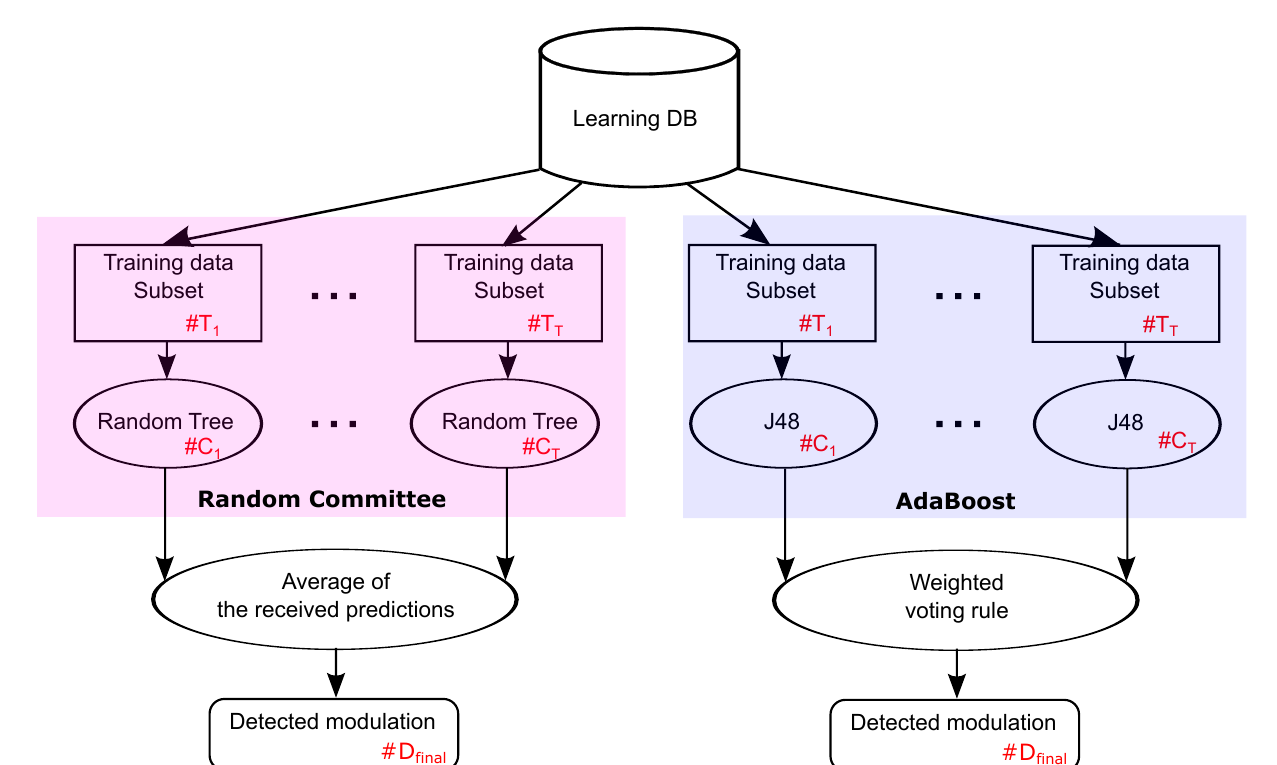
Figure 3. Random committee vs. AdaBoost processes.